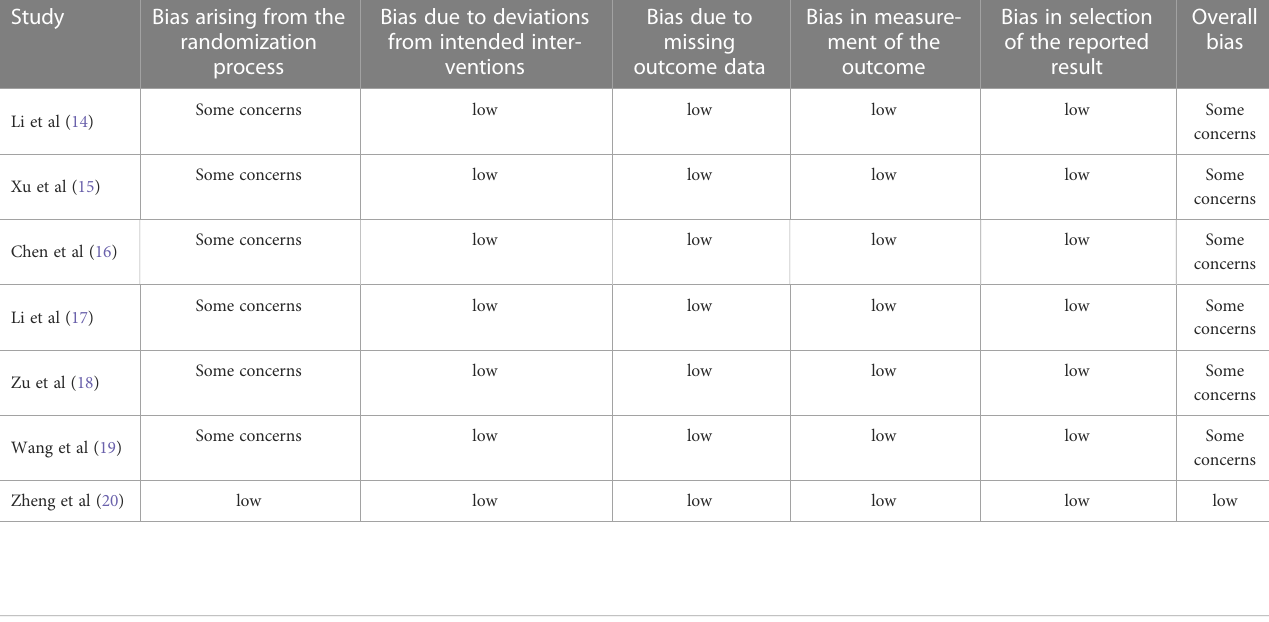
TABLE 2 Summary of the methodological quality assessment of the included studies.